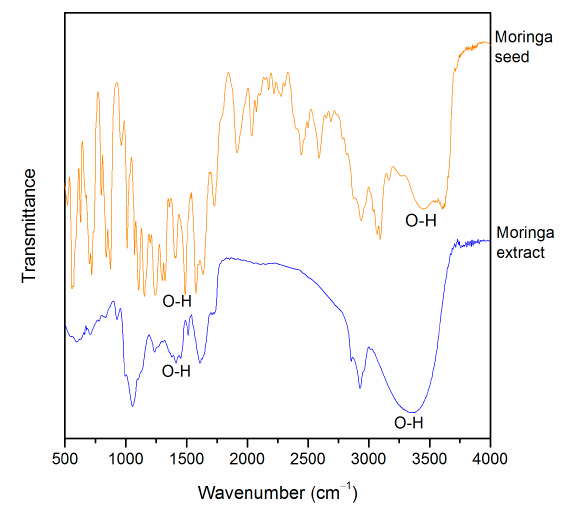
Figure 3. Fourier-transform infrared (FT-IR) spectra of M. oleifera seeds powder and extract, show the presence of hydroxyl groups of phenolic compounds.